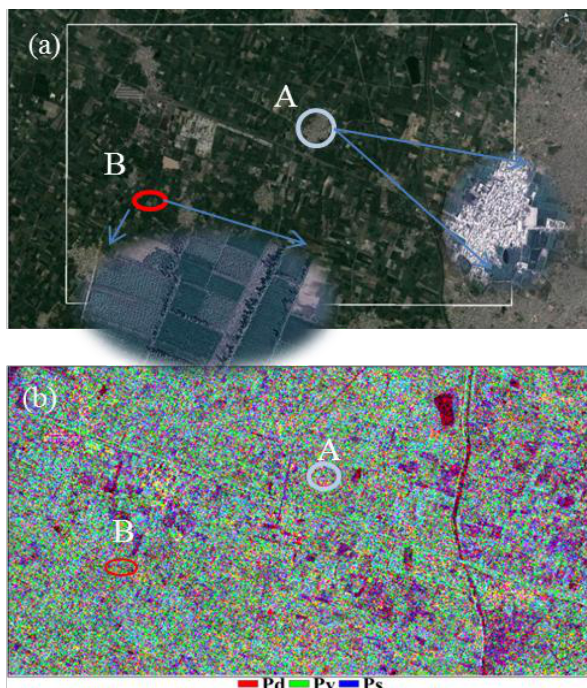
Figure 2 Google Earth image of the study area (a), Yamaguchi decomposition of RS-2 Polsar image of respected area, Circle A and B are selected patches for manmade and crop lands respectively (b).